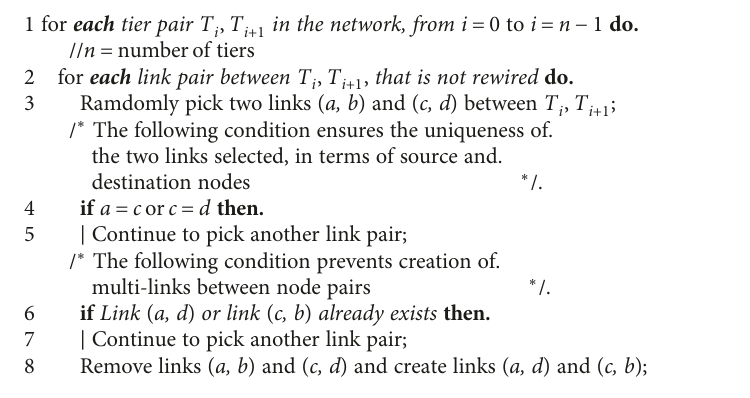
Algorithm 1: Modi fi ed degree-preserving randomizing algorithm for tiered networks.